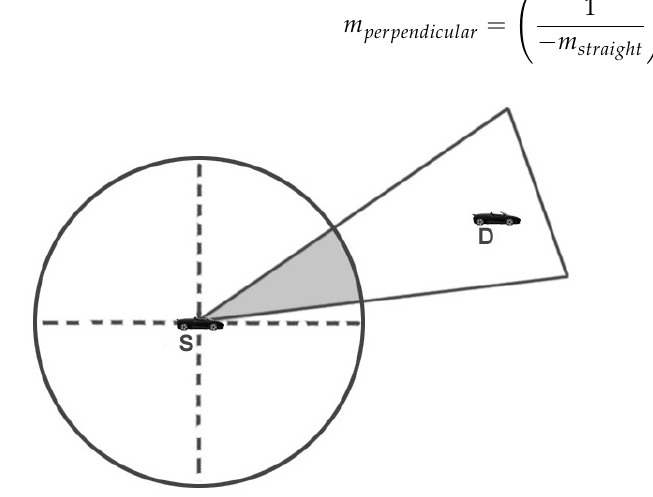
Figure 2. Clipped communication